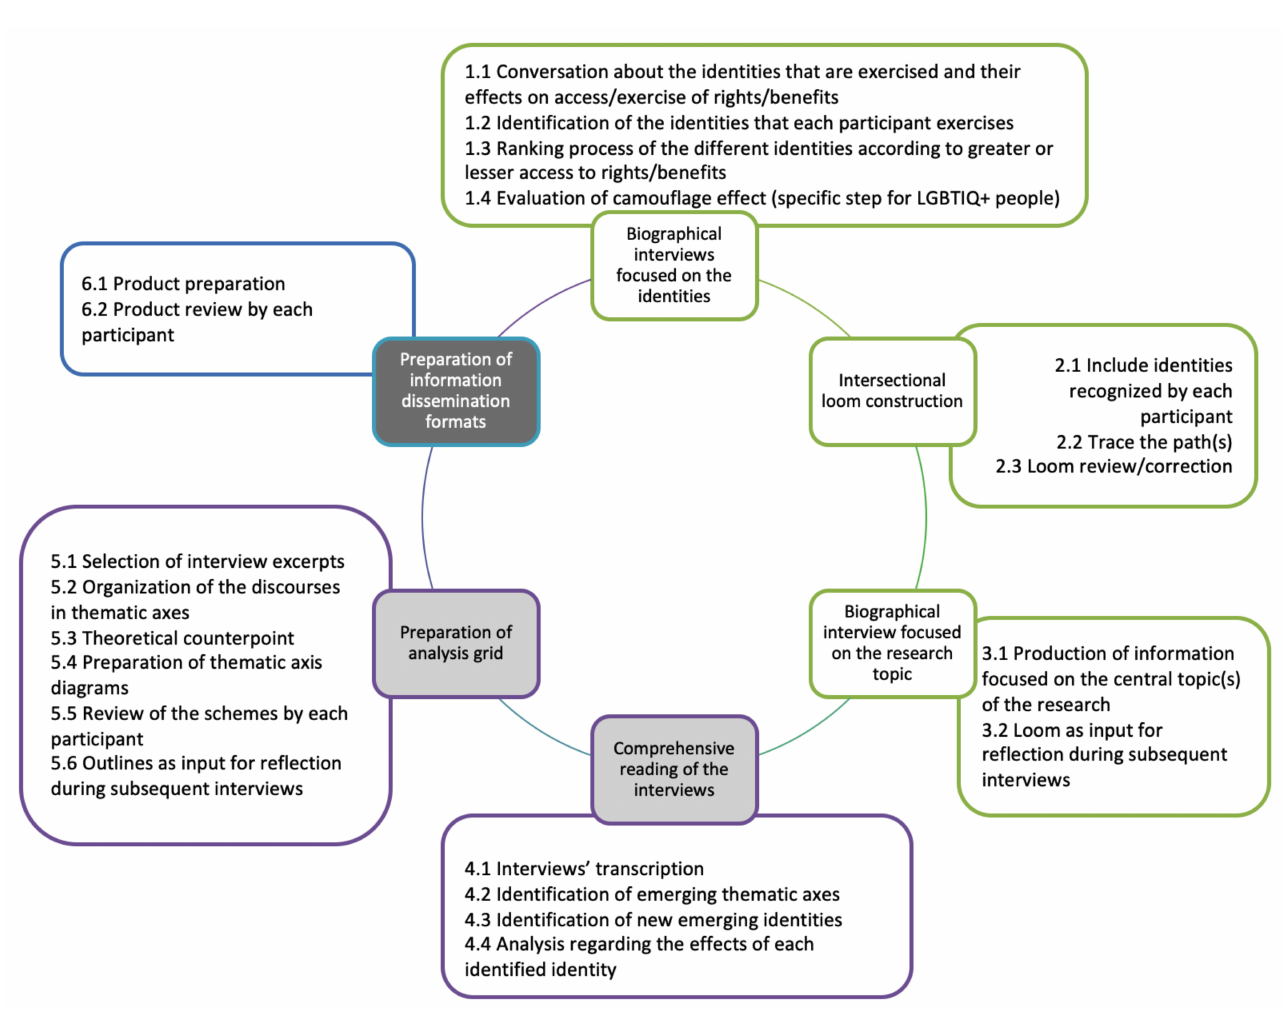
Figure 2. Research